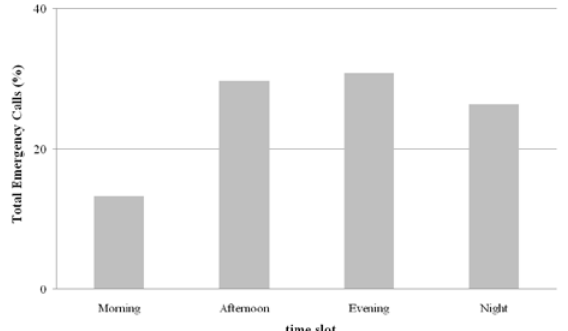
Figure 3 a. Time slot analysis of Total Emergency